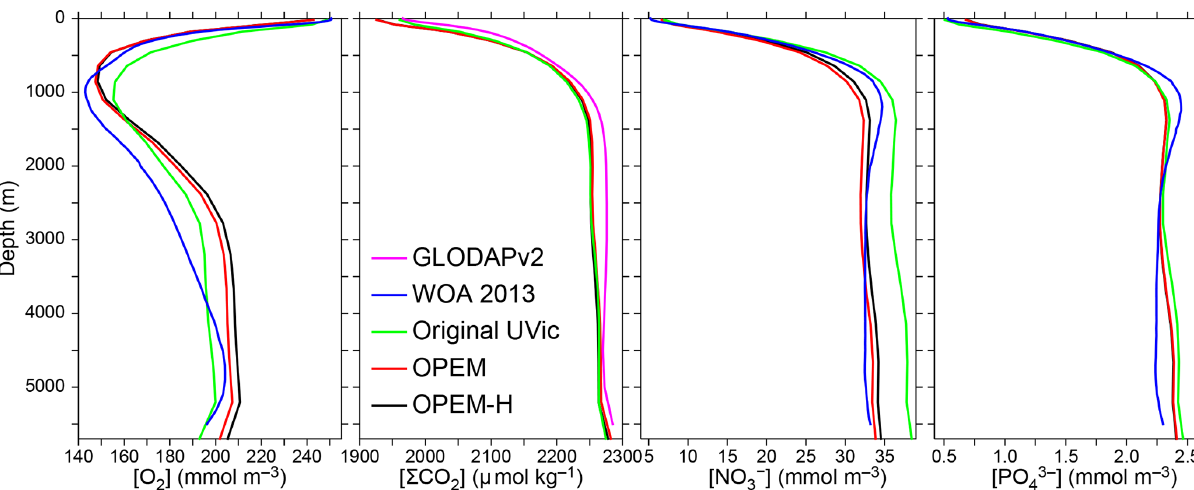
Figure 3. Globally averaged vertical profiles of O 2 , dissolved inorganic carbon (DIC) ( (cid:54) CO 2 ), NO − nitrate, and phosphate, but not DIC, are considered in the cost function. O 2 , NO − 2013; Garcia et al., 2013a, b) and (cid:54) CO 2 data from GLobal Ocean Data Analysis Project version 2 (GLODAPv2) (Key et al., 2015; Lauvset et al., 2016) are compared to our original, OPEM, and OPEM-H UVic configurations (Sect. 2.4). Note that the PO 3 − OPEM and OPEM-H.